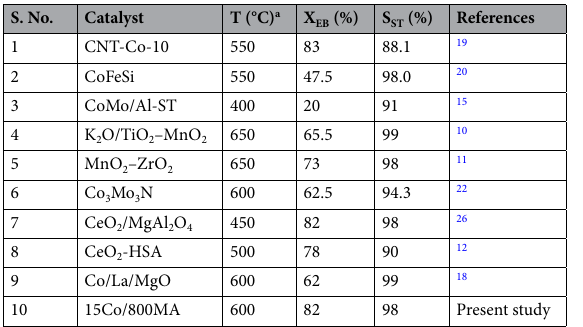
Table 4. Comparison of CO 2 assisted EB dehydrogenation activity of 15Co/800MA with the reported catalysts. a Reaction temperature for the ODH of ethylbenzene in the presence of CO 2